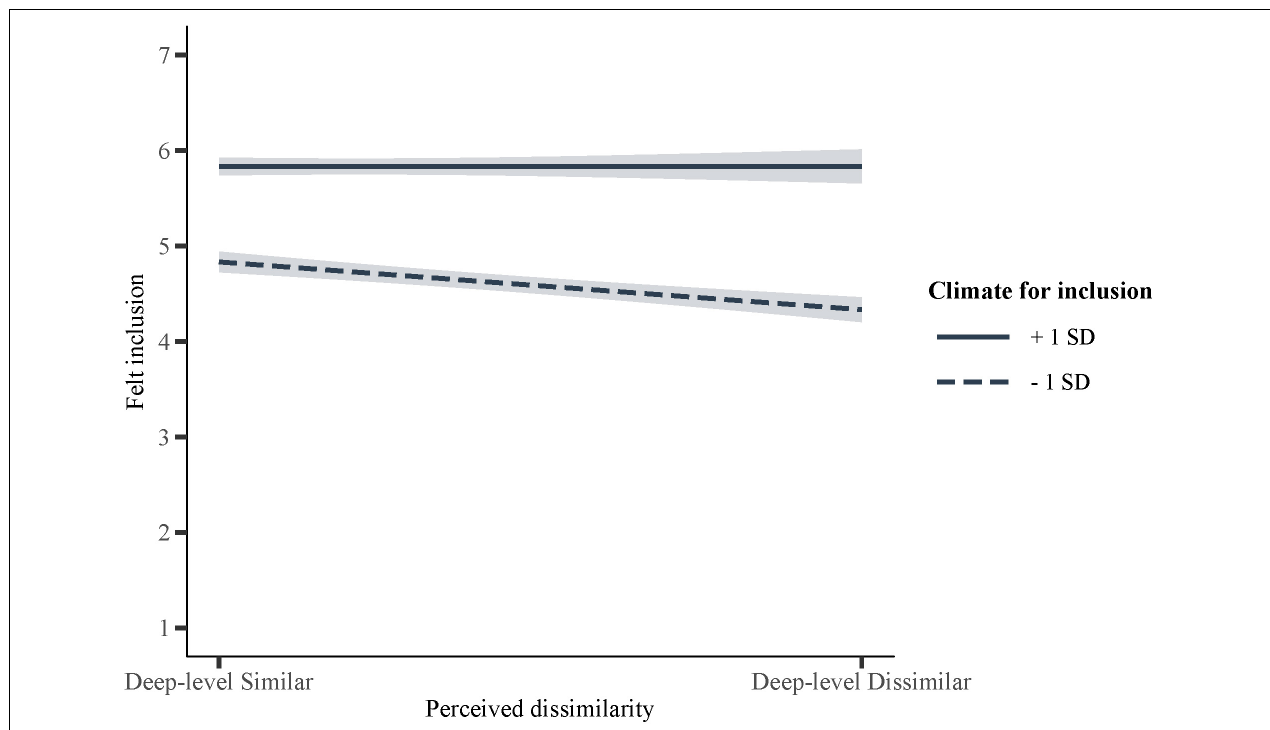
FIGURE 2 | The moderation effect by climate for inclusion on the relationship between deep-level dissimilarity and felt